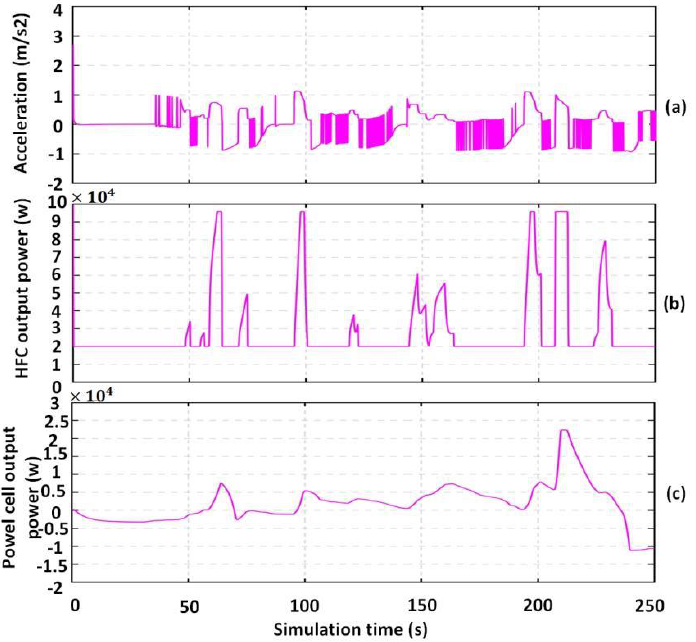
Figure 14. The simulation results of the HFC vehicle acceleration ( a ), the HFC vehicle output power ( b ), and the power cell output power ( c ). ( b ), and the power cell output power ( c